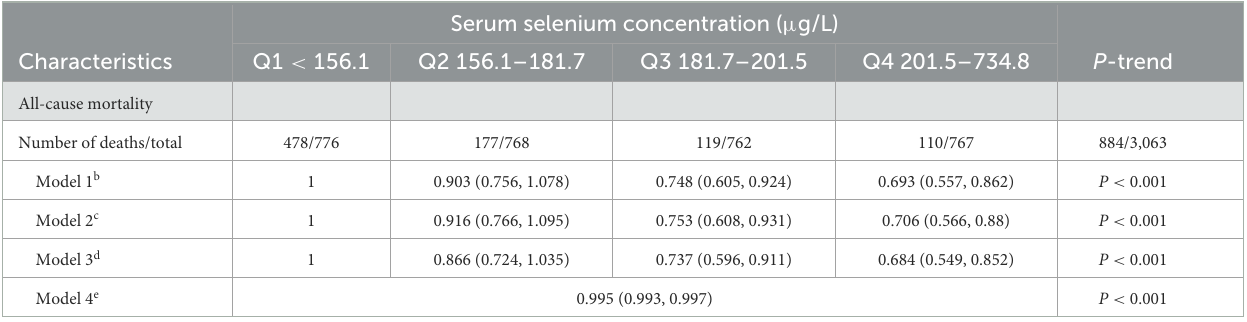
TABLE 2 All-cause mortality according to quartiles of serum selenium concentrations among patients with CKD a . Serum selenium concentration ( µ